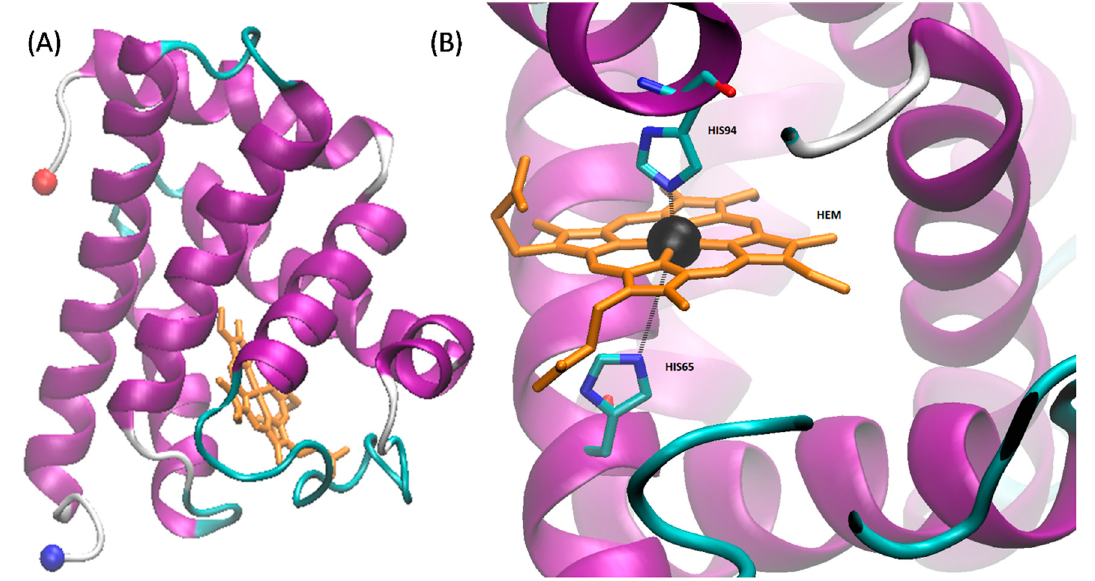
Figure 2. Structure of myoglobin from cardiac muscle of Equus caballus . The crystal structure was solved by Brayer and coworkers; downloaded from rcsb.org (1WLA) [145,173]. The structure was visualized using VMD. ( A ) 3D structure of myoglobin. The N- and C-termini are shown as red and blue spheres respectively while the heme is shown in orange (partially occluded in the structure). ( B ) Structural geometry of the heme with the iron shown in black and chelating residues highlighted . Table 2. Summary of studies done pertaining to monitoring the effects of ILs on myoglobin.